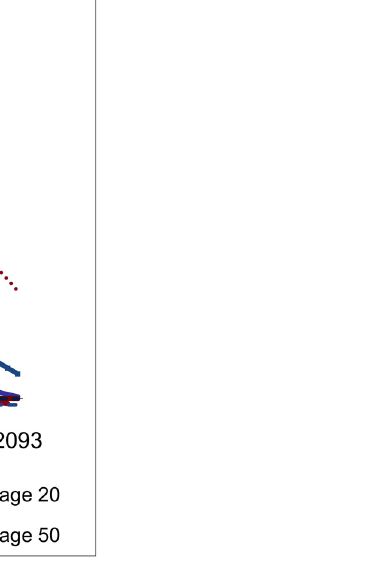
Fig 6. Projected financial savings following one male circumcision (USD, adjusted for